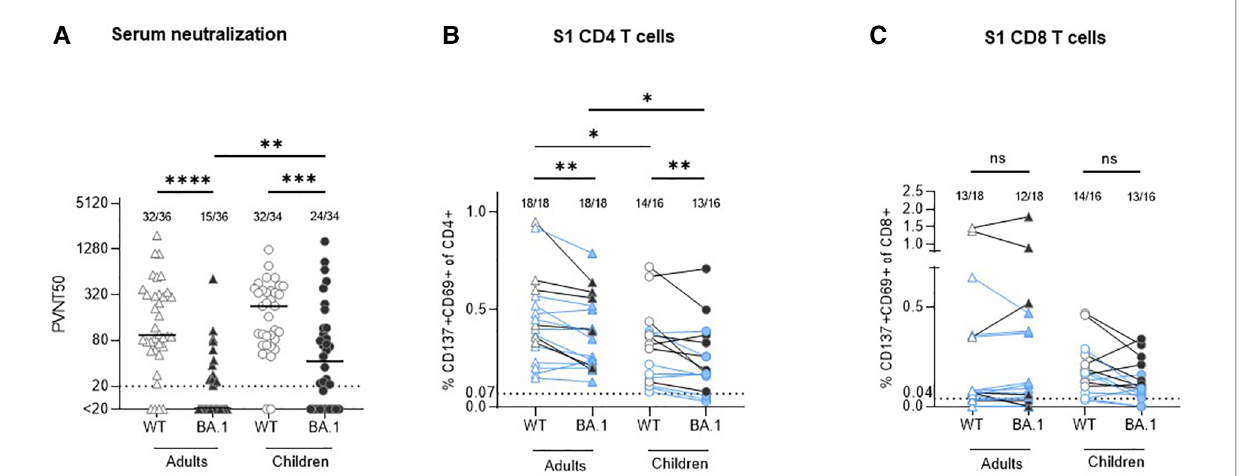
FIGURE 1 Comparison of serum neutralization capacity and S1-speci fi c T cells against Wuhan strain (WT) and omikron BA.1 (B.1.1.529.1) in adults and children circa 12 months after infection with ancestral SARS-CoV-2 strain. ( A ) Serum neutralization capacity in convalescent adults (triangles) and children (circles) was measured with a pseudovirus neutralization assay against WT (empty symbols) and BA.1 (B.1.1.529.1; fi lled symbols). The results are presented as serum dilution resulting in 50% pseudovirus neutralization (PVNT50) on cells, calculated by nonlinear regression [(inhibitor) vs. normalized response — variable slope]. The upper and lower cut-off values of this assay were set at PVNT50>81.920 and <20 (dotted line), respectively. Median values are plotted with a line. ( B,C ) In all available stored peripheral blood mononuclear cells (PBMC) samples S1-speci fi c CD4 and CD8 T cells were measured with activation-induced marker (AIM) assay using two sets of stimulating peptides (see methods). The same symbols as in the serum neutralization assay are applied; the results from participants with missing neutralization against BA.1 are marked with blue color. The results are presented as percentage of activated T cells (expressing CD137 and CD69) out of the particular T cell subset. The cut-off for positivity (dotted line) was set at 0.07% and 0.04% for CD4 and CD8 T cells, respectively; background values after stimulation with DMSO are subtracted. Numbers of positive samples out of all measured samples are displayed above the particular analysis. The Wilcoxon matched-pairs signed rank test was used for paired samples; Mann- Whitney test was used for the non-paired ones. Statistical signi fi cance was de fi ned as *** p ≤ 0.001; only statistically signi fi cant differences are marked.